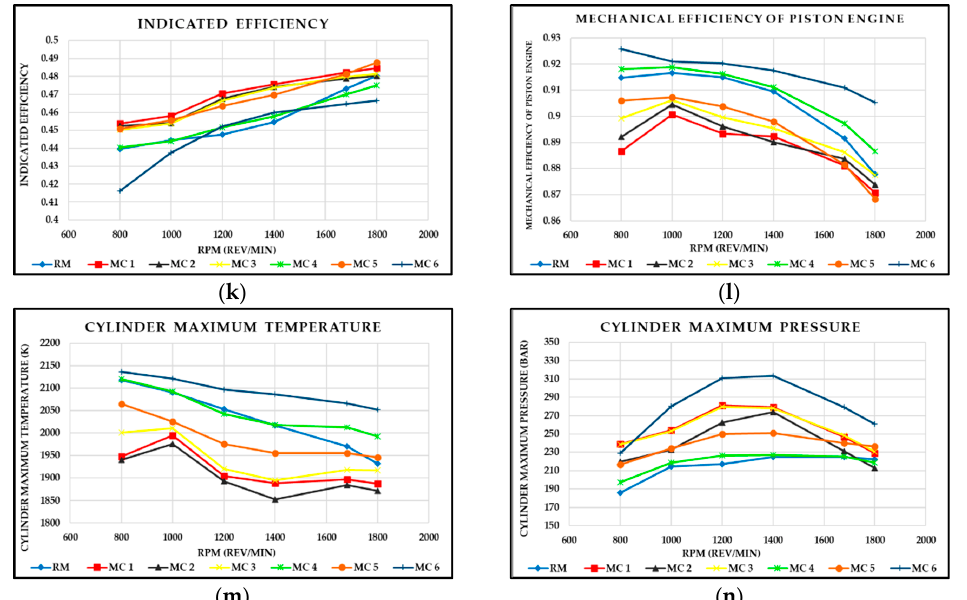
Figure 4. Results of engine performance simulation for RM and all MC models. ( a ) Engine Power (kW), ( b ) torque (Nm), ( c ) specific fuel consumption (kg/kWh), ( d ) nitrogen oxide (g/kWh), ( e ) particulate matter emissions (g/kWh), ( f ) carbon dioxide (g/kWh), ( g ) summary emissions of PM and NOx, ( h ) brake mean effective pressure (bar), ( i ) volumetric efficiency, ( j ) AFER ( λ or Lambda), ( k ) indicated efficiency, ( l ) mechanical efficiency of piston engine, ( m ) cylinder maximum temperature (K) and ( n ) cylinder maximum pressure (bar).